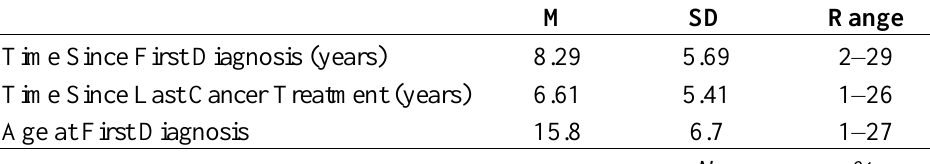
Table 2. Health and survivorship characteristics of the